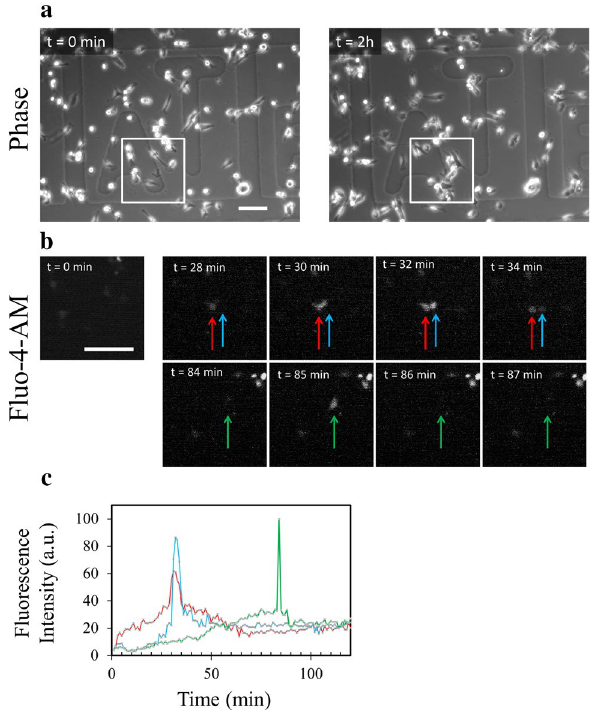
Figure 3. Highlighting membrane ruptures in migrating MDA-MB-231 cells. MDA-MB-231 cells were seeded on a glass coverslip coated with collagen I for 24 h, then incubated for 1 h at 37 °C with 2.5 µM Fluo-4-AM (white) and finally kinetics study using fluorescence microscopy was performed for 2 h. ( a ) Images in phase- contrast microscopy were acquired before and after the kinetics study. ( b ) Fluorescence intensity variations of intracellular Fluo-4-AM studied in the course of time. Each colored arrow points out a cell of interest exhibiting a strong variation of the fluorescence intensity. A strong increase of fluorescence intensity is particularly observed at t = 32 min (blue and red arrows) and t = 85 min (green arrow). A recovery of fluorescence intensity to a basal level is observed at t = 34 min (blue and red arrows) and t = 86 min (green arrow). Scale bar: 100